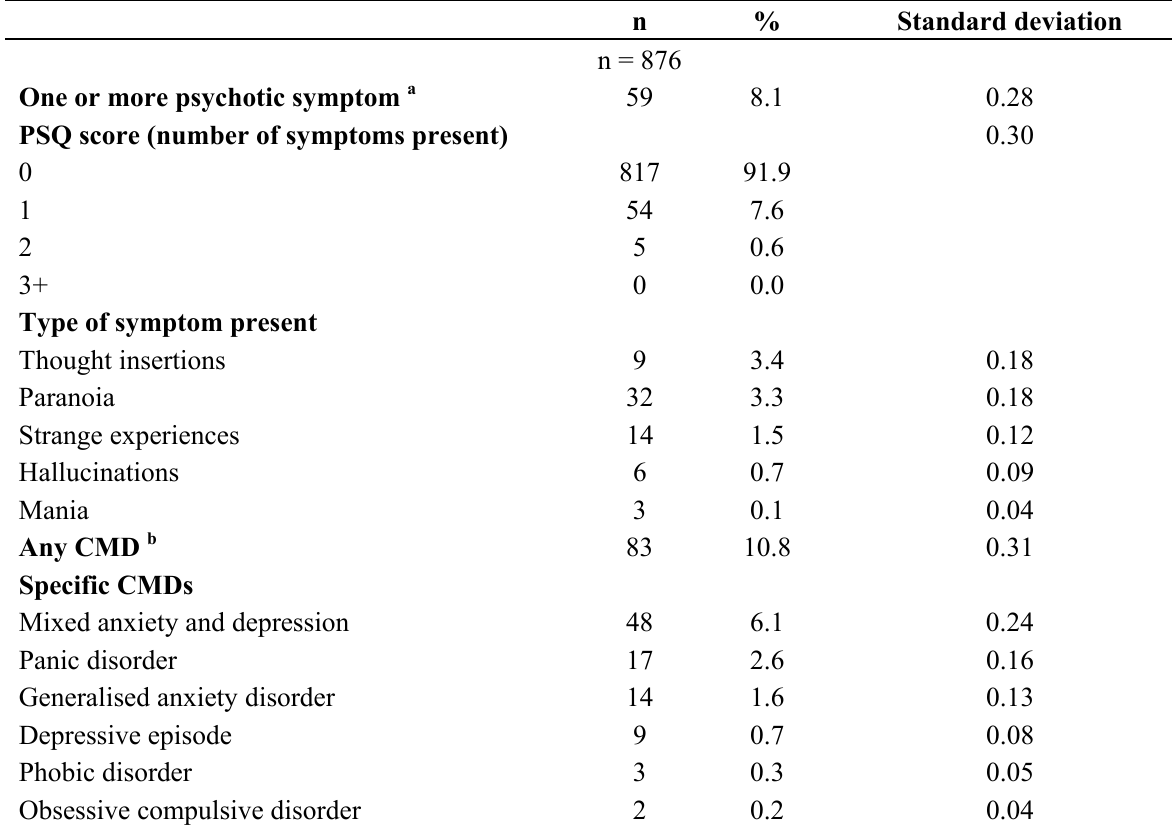
Table 1. Prevalence of psychotic symptoms and CMD in a community based sample in Maseno.